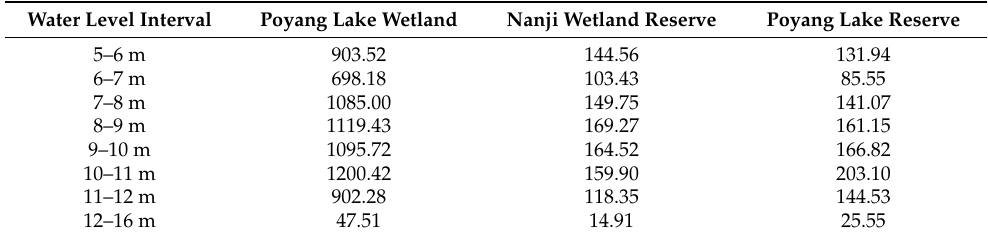
Table 2. Areas of the sustainable crane habitats in Poyang Lake wetland and two national nature reserves within various water level intervals (km 2